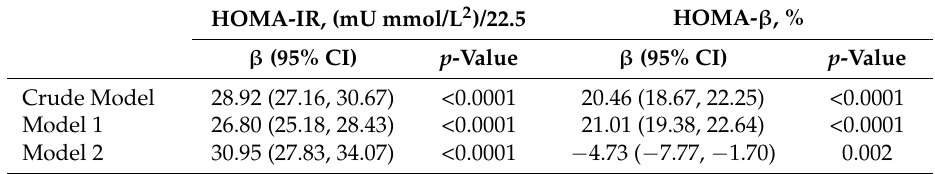
Table 2. Cross-sectional associations of BCAAs with insulin resistance and pancreatic β -cell function.